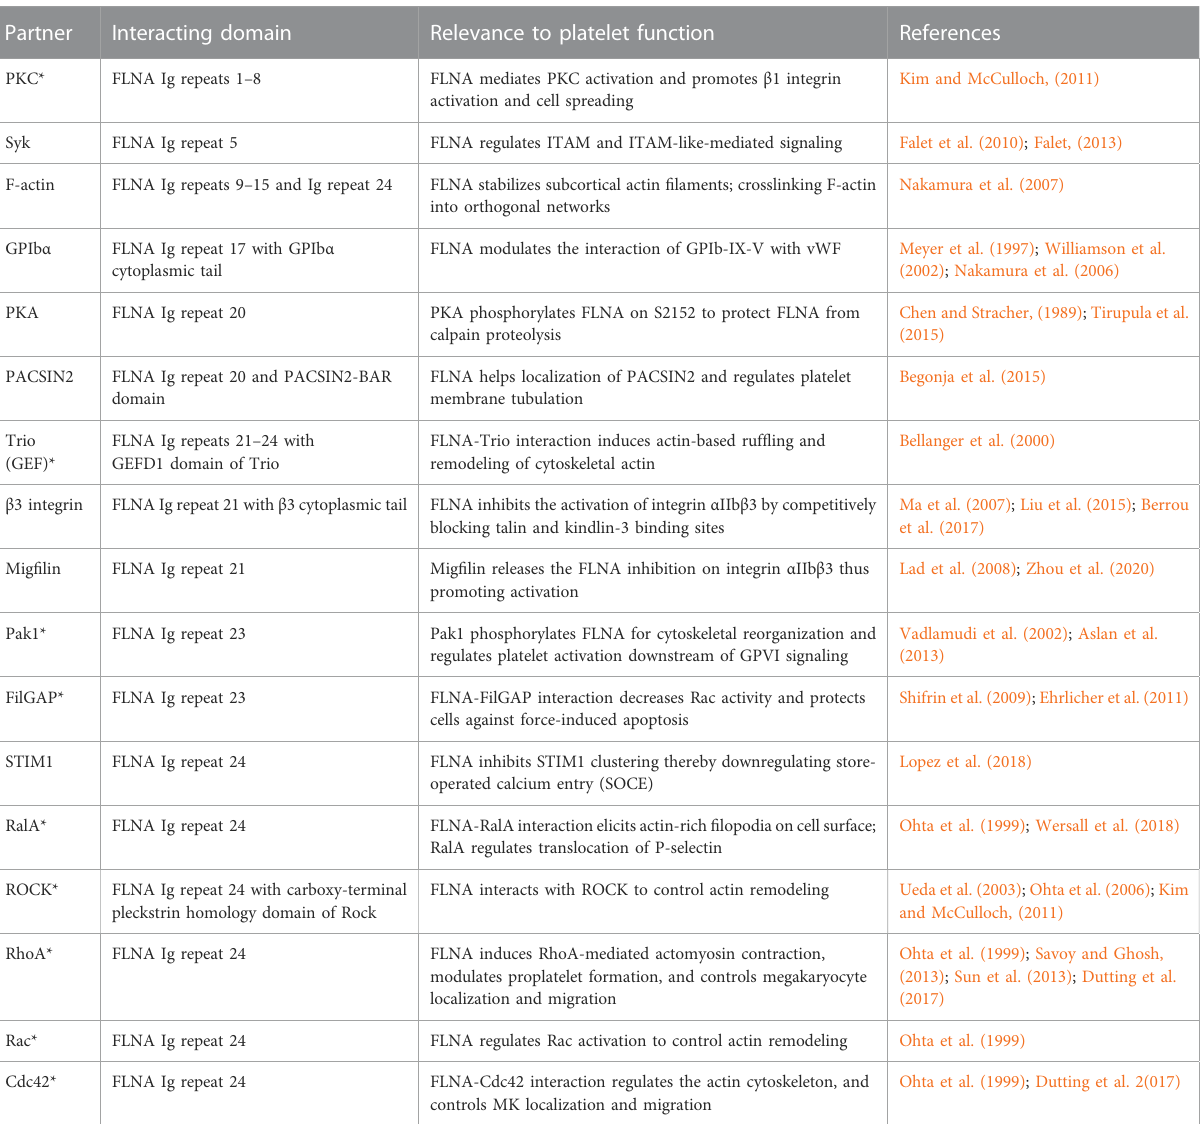
TABLE 1 Filamin A (FLNA) interacting